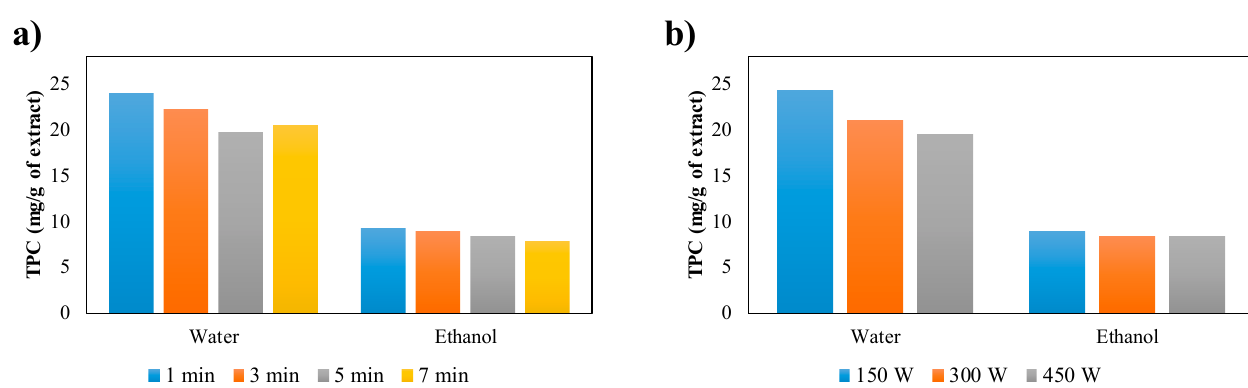
Figure 4. Effect of the process parameters on TPC: ( a ) solvent and extraction time and ( b ) solvent and power. Results expressed on a dry basis. Standard deviation by ANOVA for TPC = 0.9.